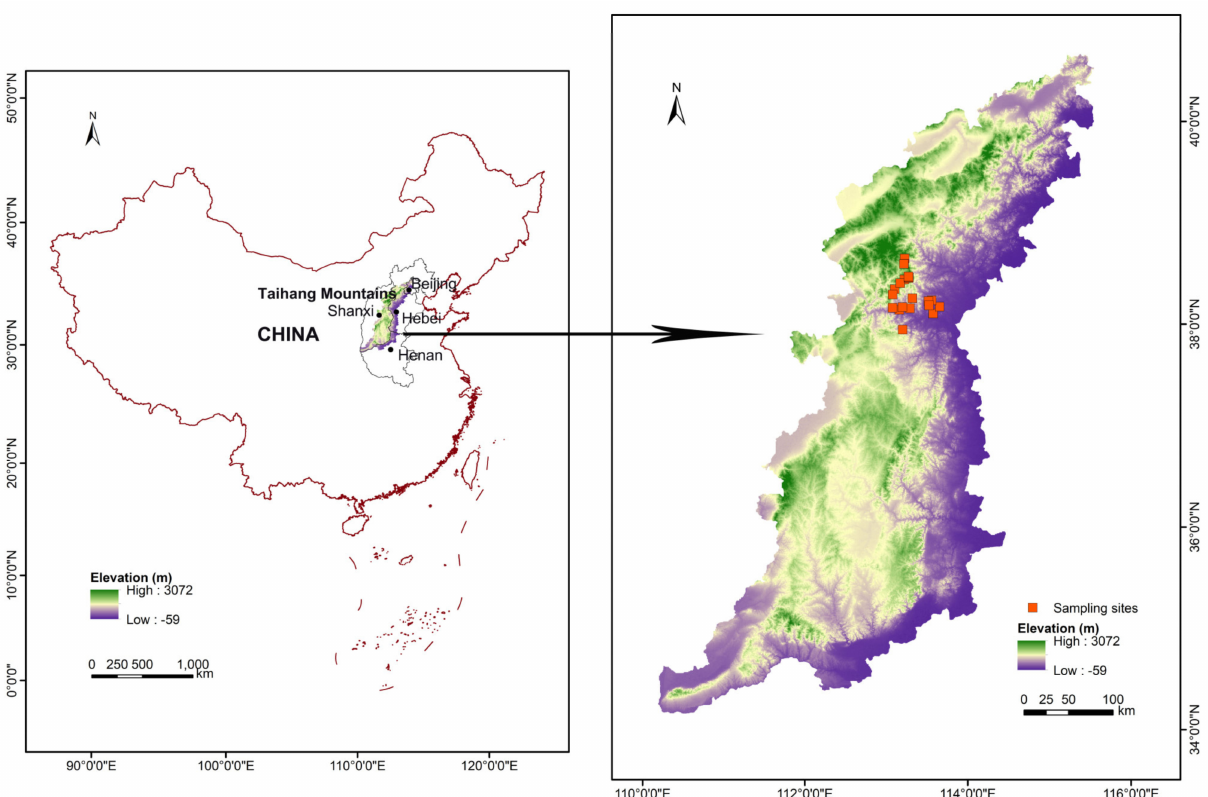
Figure 1. A map depicting the location of Taihang Mountains in northern China (left panel) and an expanded map depicting elevation and sampling sites in the study